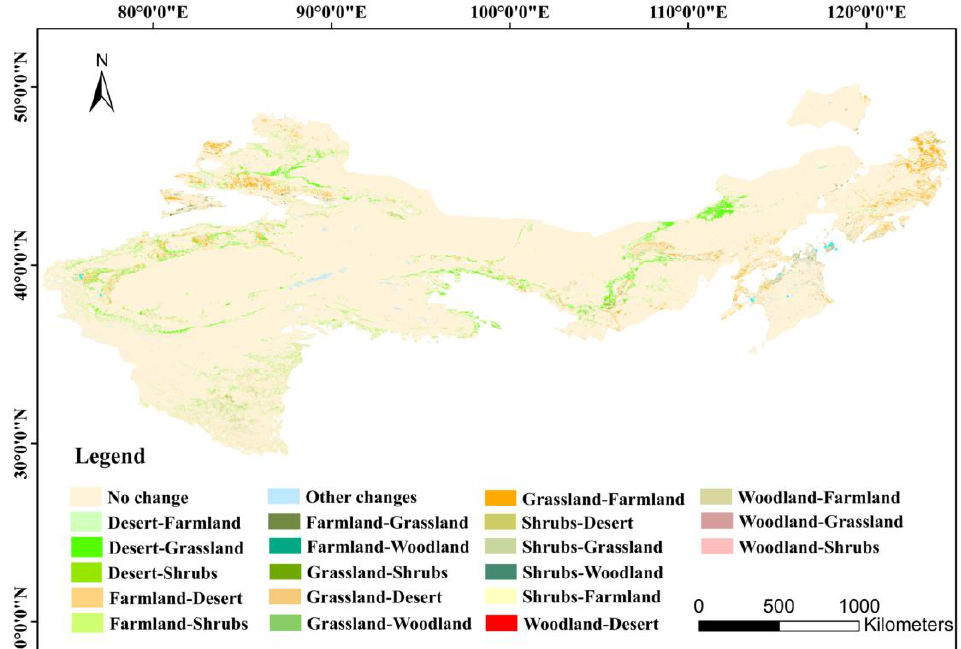
Figure 9. Land-use changes in the study area within the last 20 years. We focused mainly on the changes in vegetation and the desert. The remaining land types did not change much, and we at- tributed them to other changes.